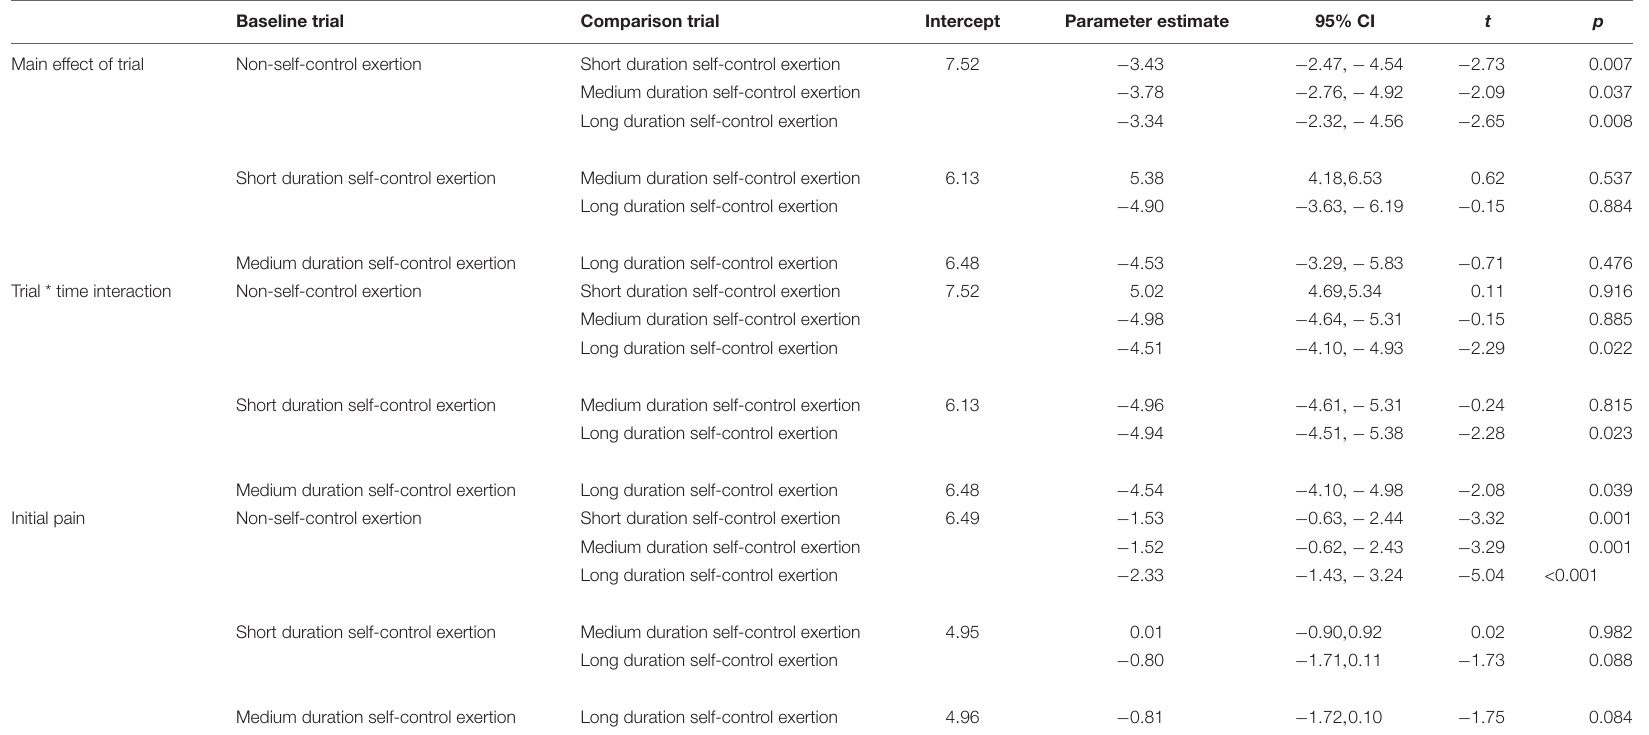
TABLE 2 | Results of the multilevel models conducted for